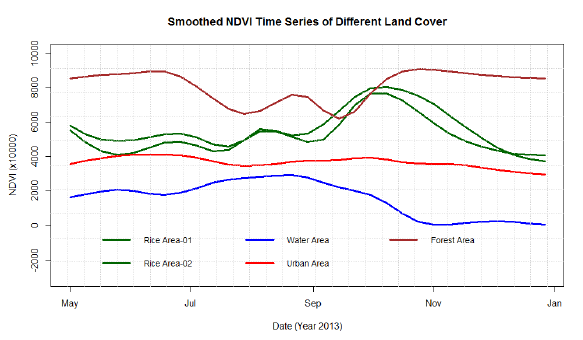
Figure 3: NDVI Time series graphs of different land cover